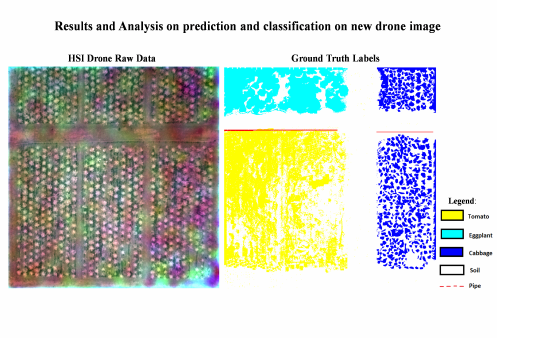
Figure 11: HSI Raw imagery and ground truth labeled image